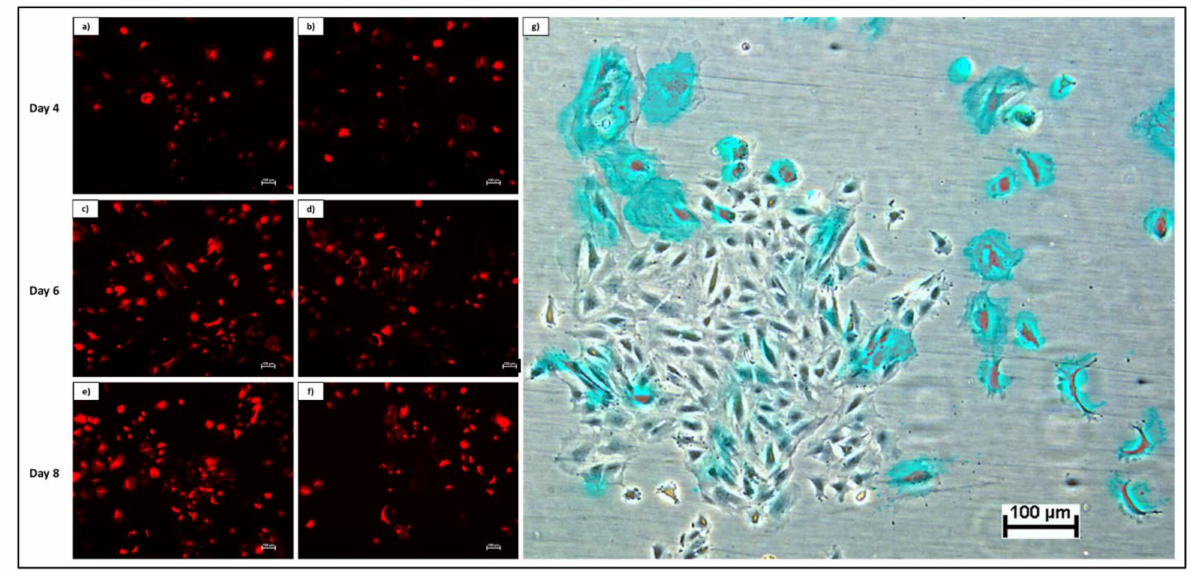
Figure 3. Fluorescent imaging of rDPSCs transduced with DsRed over time in the initial passage. Images at 5 × magnification depict cells at day 4 ( a , b ), day 6 ( c , d ), and day 8 ( e , f ) of growth. Overlay of phase contrast and fluorescent imaging at day 8 show DsRed-expressing cells (shown in blue for enhanced contrast) within overall population ( g ).